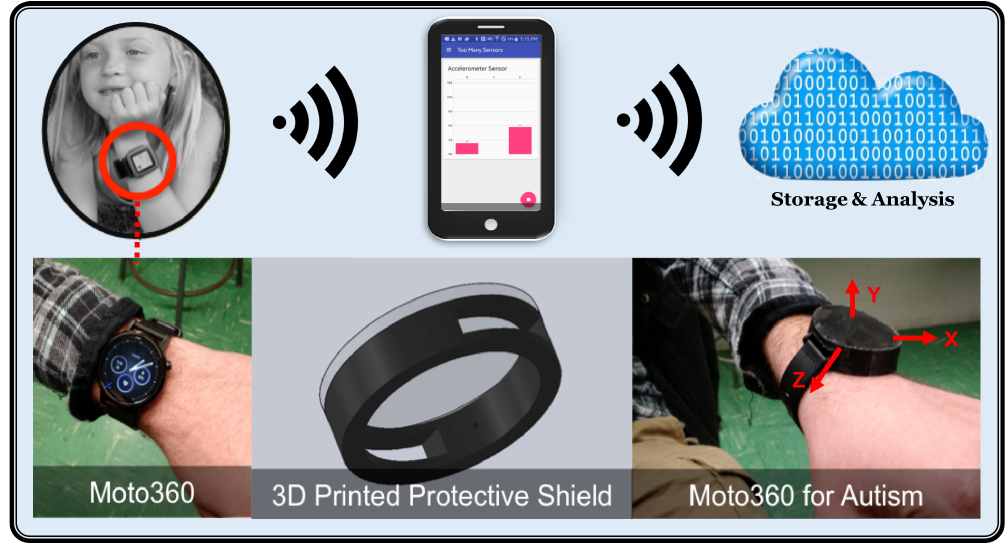
Figure 1. WearSense system architecture for monitoring autism behavior